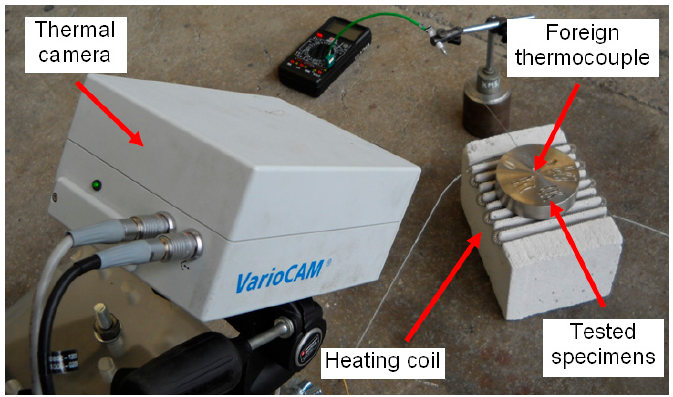
Figure 3. Bench for IR camera calibration [6].